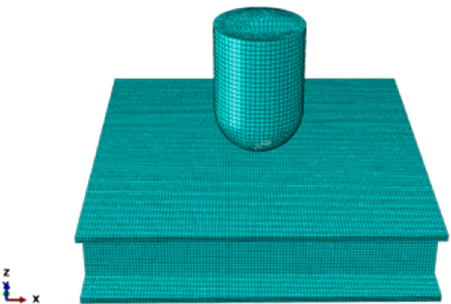
Figure 2: Finite element model of low - velocity impact of composite grid sandwich